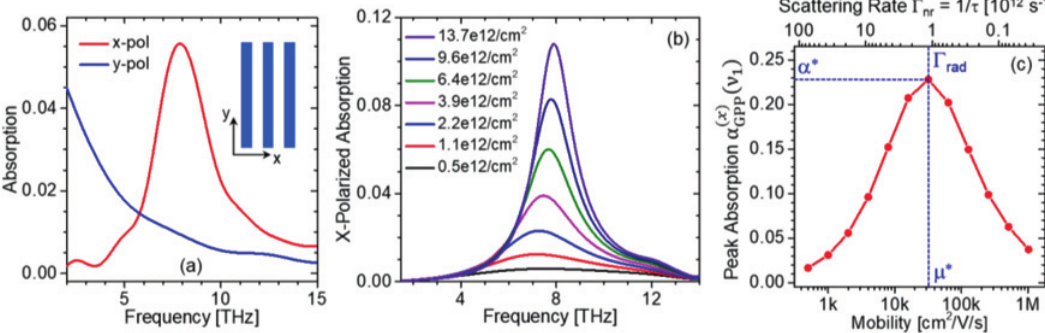
Figure4: Plasmonicabsorptioningraphenenanoribbons.(a)Absorptionspectrumforincidentlightwithpolarizationparallel(bluetrace)and perpendicular (red trace) to the nanoribbons, for μ = 2,000 cm 2 /Vs and N = 5.4 × 10 12 cm − 2 . The nanoribbons have 530 nm width and 1000 nm center-to-center spacing. (b) X-polarized absorption spectra for different nanoribbons at different carrier densities. The ribbon widths, selected to produce approximately the same peak absorption frequency, vary from 200 to 800 nm in steps of 100 nm in order of increasing carrierdensity.Ineachsample,themobilityis μ =2,000cm 2 /Vsandthegeometrical fi llfactoris50%.(c)Peakabsorptionofthestructureof(a) for x -polarizedlightversusmobility(bottomaxis)andplasmonicnonradiativedampingrate(topaxis).Forsimplicity,theSiO 2 gatedielectricis modeled with a real dielectric constant in these simulations, so that the calculated absorption values are due entirely to the graphene